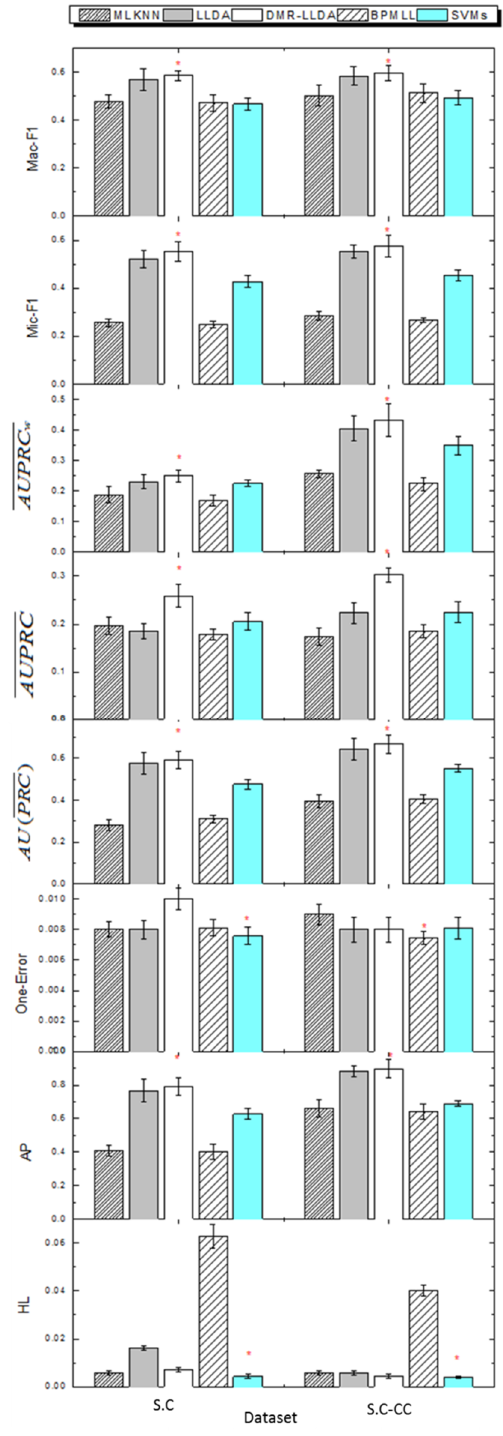
Figure 5. The comparisons between DMR-LLDA, LLDA, back propagation for multi-label learning (BPMLL), support vector machines (SVMs), and multi-label k -nearest neighbor (MLKNN) in two datasets. The red asterisk represents the best results in each dataset.